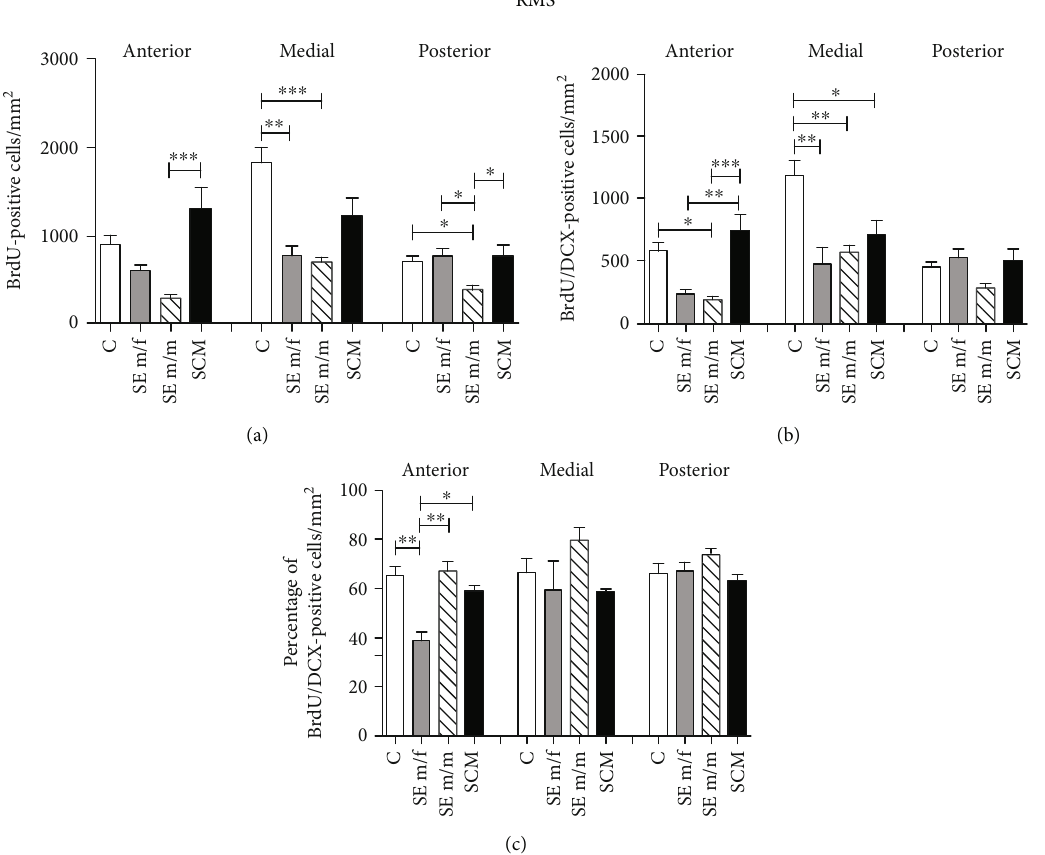
Figure 5: Cell proliferation, total BrdU/DCX-positive cells, and percentage of BrdU/DCX-positive cells in the RMS (a – c) for the control (C), social exposure to a female (SE m/f), social exposure to a male (SE m/m), and social cohabitation with mating (SCM) male voles. One-way ANOVA followed by Bonferroni ’ s post hoc tests. ∗ p < 0 : 05 and ∗∗ p < 0 : 01 . Results of ANOVA analyses are provided in the text. Anterior RMS: C ( n = 6 ), SE m/f ( n = 3 ), SE m/m ( n = 6 ), and SCM ( n = 6 ); medial RMS: C ( n = 7 ), SE m/f ( n =4 ), SE m/m ( n = 5 ), and SCM ( n = 6 ); and posterior RMS: C ( n = 7 ), SE m/f ( n = 6 ), SE m/m ( n = 6 ), and SCM ( n = 5